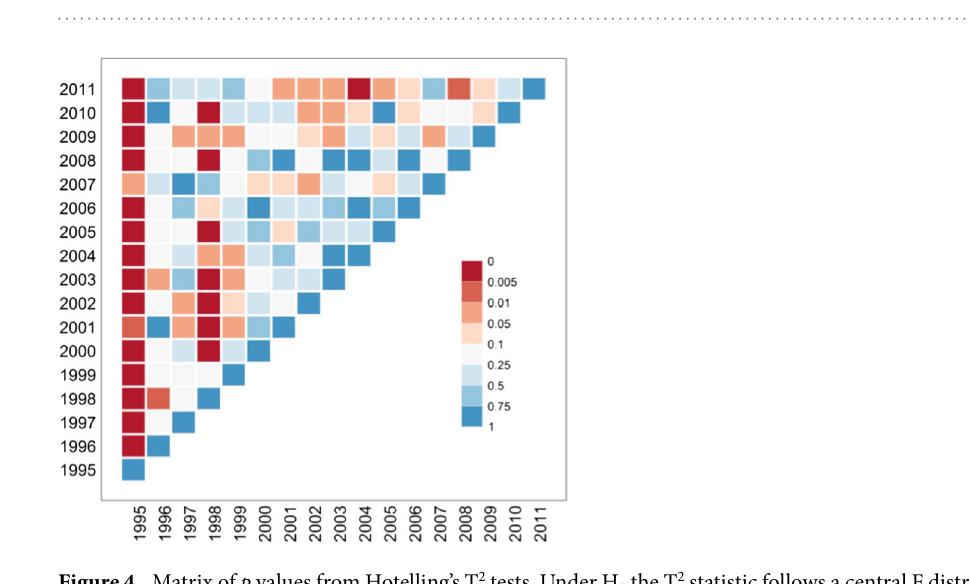
Figure 3. K-function plots studying clustering phenomena among various categories of reported TB cases compared with completely random spatial pattern (dashed line). ( a ) Annual spatial clustering curves combining all TB cases over seventeen years from 1996 to 2011, ( b ) Annual spatial clustering patterns of resident TB cases observed over the same time period, ( c ) Annual spatial clustering patterns among non-resident reported TB cases during 1996–2011, ( d ) Annual spatial clustering curves studying clustering of non-resident TB cases around resident TB cases reported during 1996–2011, ( e ) Spatial clustering curves studying clustering of resident and non-resident reported TB cases in three high TB (Jurong West, Bedok and Tampines) zones and low TB zones in 2000, ( f ) Spatial clustering curves showing clustering of resident and non-resident reported TB cases in three high TB (Jurong West, Bedok and Tampines) zones and low TB zones in 2010.